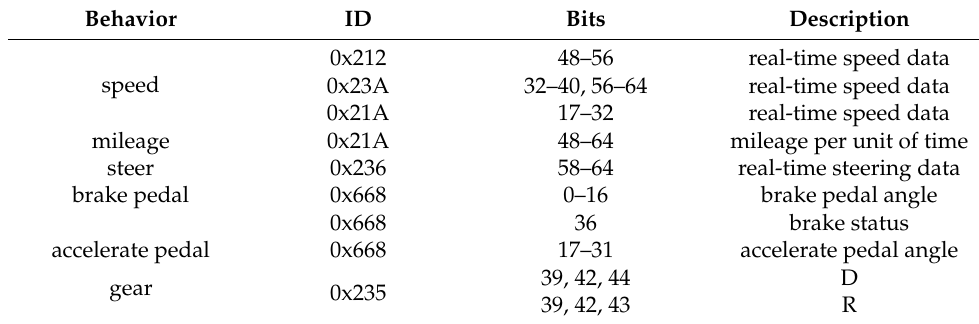
Table A1. Another vehicle reverse